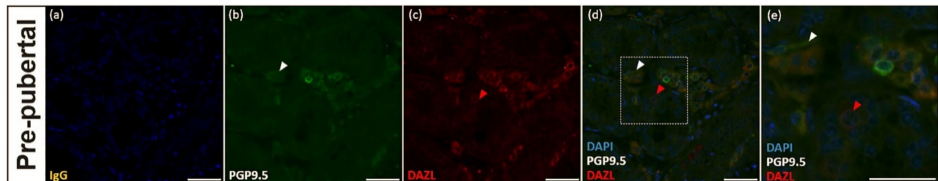
Figure 3. Immunostaining of PGP9.5 and deleted in azoospermia-like (DAZL) in the seminiferous tubules of pre-pubertal donkeys. Testicular tissue stained with IgG showed no immunolabeling ( a ). PGP9.5 immunolabeling was detected in the cytoplasms of myoid cells ( b , d , e ). The DAZL immunolabeling was detected in the cytoplasm of germ cells ( c , d , e ). The white arrowhead indicates myoid cells immunolabeled with PGP9.5. The red arrowhead indicates germ cells immunolabeled with DAZL. The size bar = 50 µ